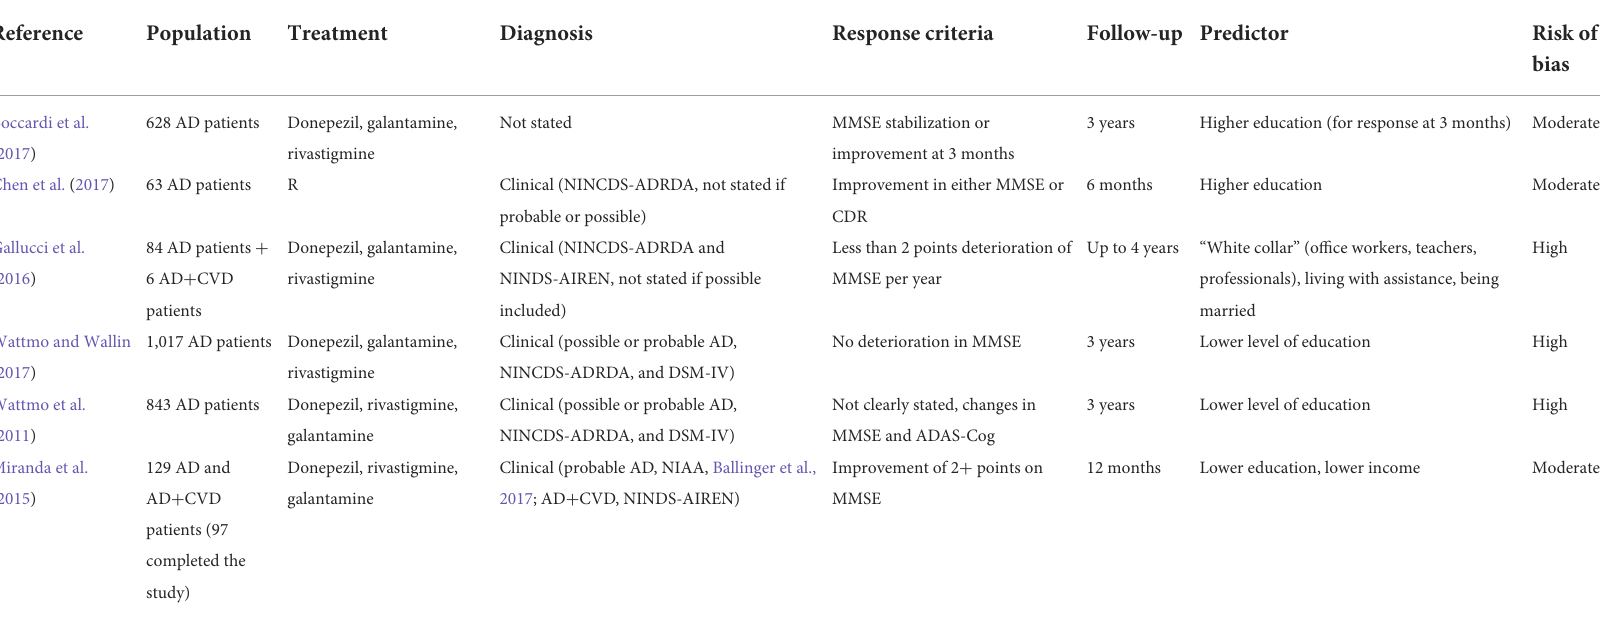
TABLE 5 Cognitive